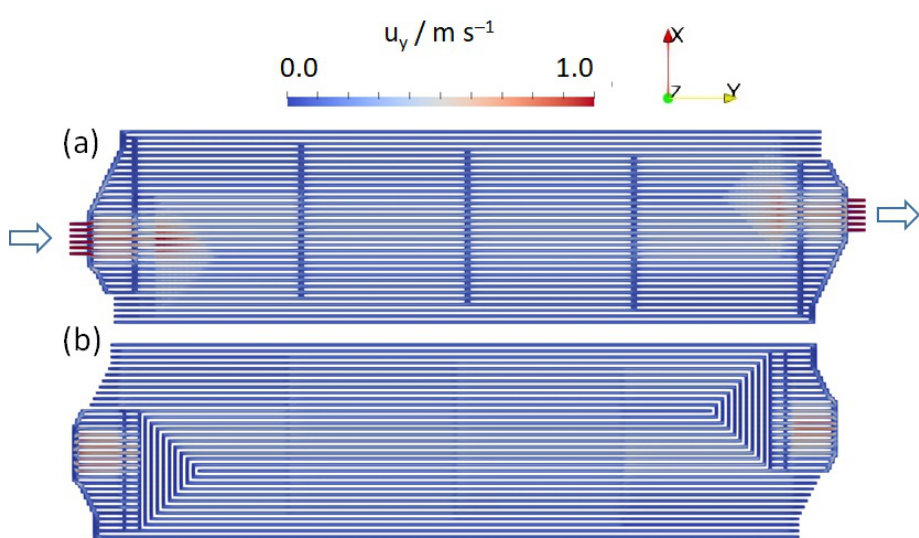
Figure 16. Fluid velocity (y-component) inside the coolant flow field for the MAX condition. ( a ) Cross section at half anode channel depth and ( b ) at half cathode channel depth.